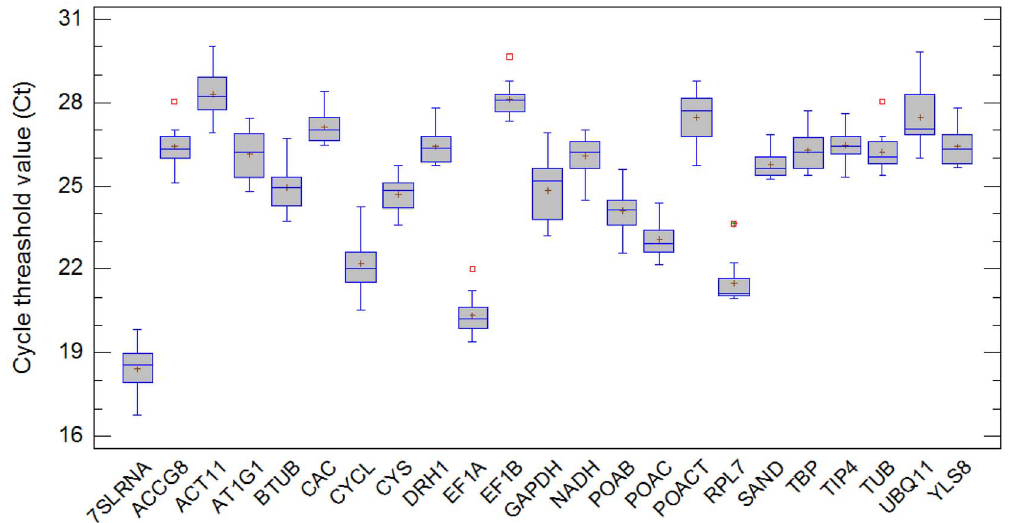
Figure 1. Expression data displayed as Ct values for each reference gene in all 12 samples. The figure summarizes data through 5 statistics: the markers in the box indicate average cycle threshold (Ct) values, squares indicate the presence of outliers, the box corresponding to an individual reference gene indicates the 25% and 75% percentiles, whiskers represent the maximum and minimum values and the median is depicted by the line across the box.